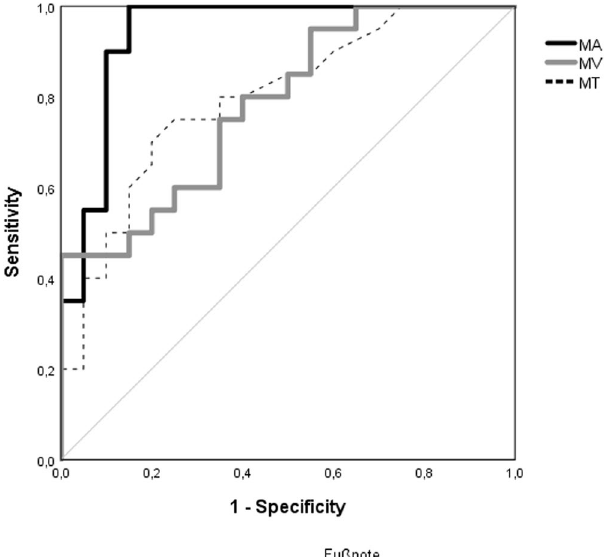
Figure 1. ROC curve for mean blur rate (MBR) in the whole optic nerve head area (MA), in the area of the big vessels (MV) and the microvasculature (MT). An area under the ROC curve (AUROC) of 1.0 represents perfect discrimination, whereas an AUROC of 0.5 can be considered chance discrimination.